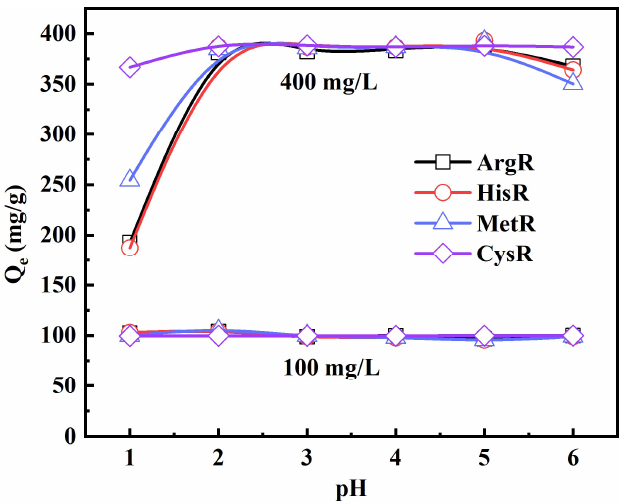
Figure 2. Effect of pH on Au (III) adsorption by amino acid resins (C 0 = 100 and 400 mg/L, adsorbent mass = 10 mg, volume = 10 mL, T = 30 °C, contact time = 24 h).